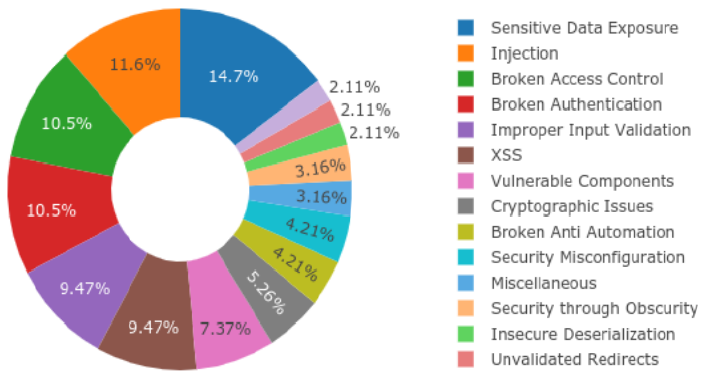
Figure 4. OWASP Juice Shop vulnerability categories [45]. Table 3. Injection vulnerabilities in OWASP Juice Shop.